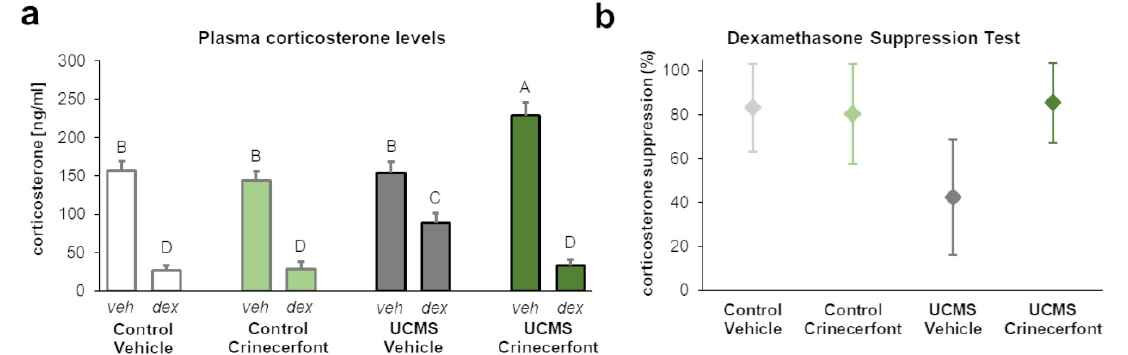
Figure 3. The CRF-R1 antagonist crinecerfont treatment increased basal plasma corticosterone levels and improved HPA axis negative feedback under chronic stress. Plasma corticosterone levels were collected during dark phase and 2 h following vehicle (veh, 0.9% NaCl) or dexamethasone (dex, 0.1 mg/kg, ip) in order to assess basal corticosterone levels and post-dexamethasone corticosterone levels, respectively. ( a ) The 5-week crinecerfont treatment (20 mg · kg − 1 · day − 1 , ip) increased the basal levels of plasma corticosterone uniquely in mice exposed to the unpredictable chronic mild stress (UCMS). UCMS resulted in higher plasma corticosterone levels following dexamethasone administration, an effect reversed by crinecerfont treatment. n = 7 per group; the groups not sharing the same letter (A, B, C or D) were found to be significantly different ( p < 0.05). Data represent mean ± sem. ( b ) Confidence intervals (95%) of the dexamethasone-induced suppression of plasma corticosterone levels computed from data of panel ( a ). The results revealed lower corticosterone suppression levels in UCMS ‐ vehicle mice compared with other groups. n = 7 per group.